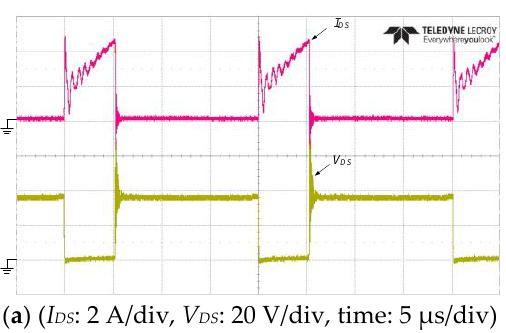
Figure 14. Measured waveforms of switch voltage V DS and current I DS under 25% of the full-load